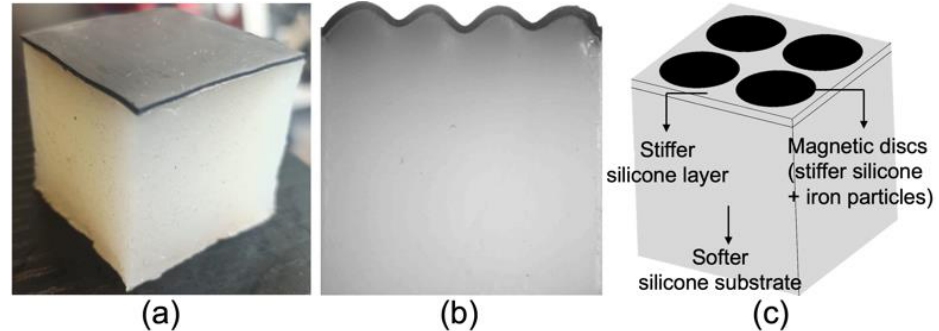
Figure 1. ( a ) System made of a stiffer MRE layer (Ecoflex 00-50 and 20 vol% CIP, thickness 0.8 mm) bonded to a softer pure silicone substrate. The whole system measures 40 mm × 40 mm × 40 mm and corresponds to the one used in [48]. ( b ) A 2.5D wrinkling pattern via collaborative instabilities, obtained when this system is submitted to a lateral compression of 20% and a 0.4 T magnetic field perpendicular to the layer. ( c ) Schematic of the heterogeneous magnetoactive layer targeted in this study, comprising of a set of four magnetoactive discs (17 mm in diameter) embedded in a non- magnetic square (40 mm × 40 mm in size) and fused to a soft non-magnetic